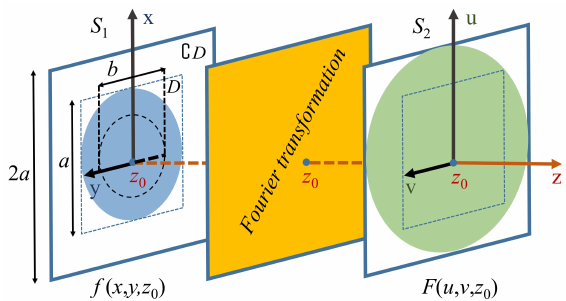
Figure 3. Geometry of the problem with zeros padded.